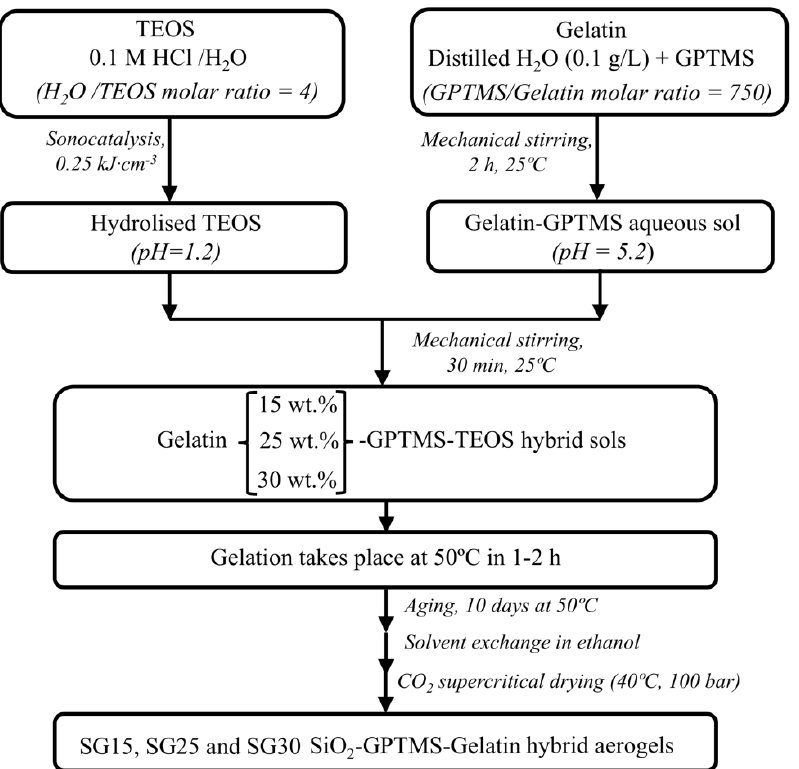
Figure 14. Scheme of the synthesis procedure for silica/GPTMS/gelatin hybrid aerogels. GPTMS/gelatin of 750 was kept constant in all cases and samples were named SGx, where x = 15, 25, 30, indicating that the gelatin wt.% referred to the theoretical silica content obtained from TEOS and GPTMS precursors.